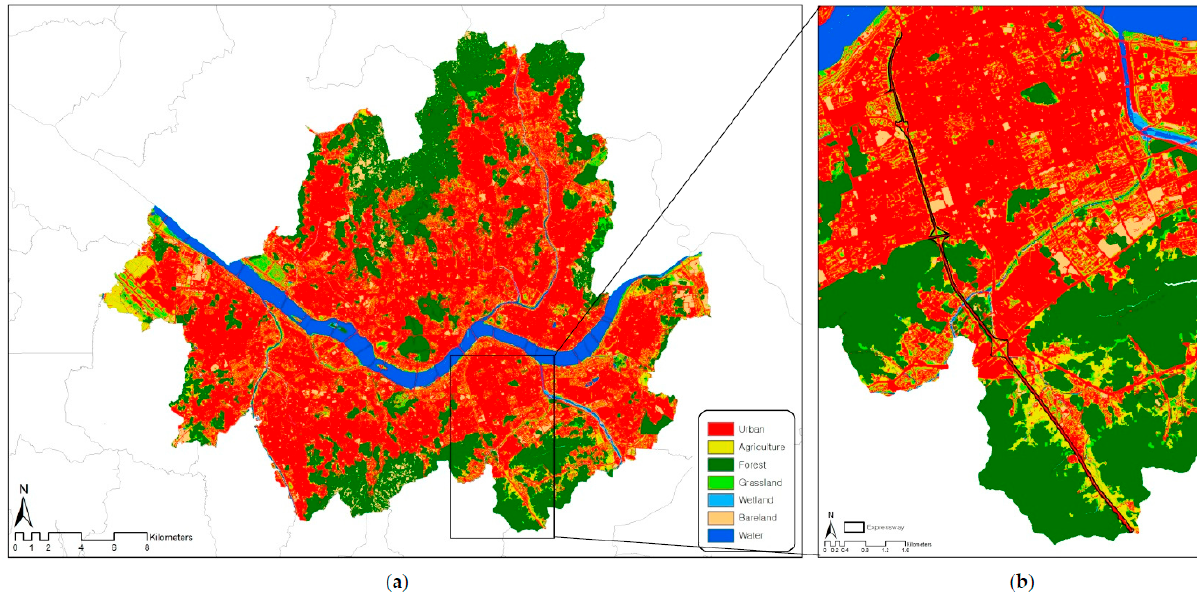
Figure 1. Study area ( a ) Seoul city and ( b ) Gyeongbu Expressway.